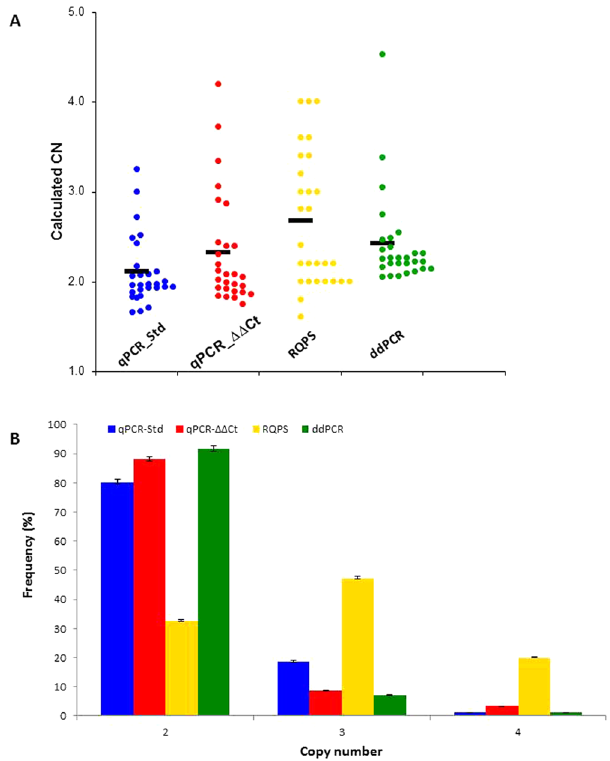
Figure 3. CN prediction across different methods. ( A ) Scatterplot of predicted CN per individual and genotyping method. Each dot represents the CN predicted for each individual, predicted CN corresponds to the calculated number without correction to expected CN. The black lines show the mean of predicted CN. ( B ) Direct comparison of the predicted CN frequency across different methods. Error bars show 95% confidence